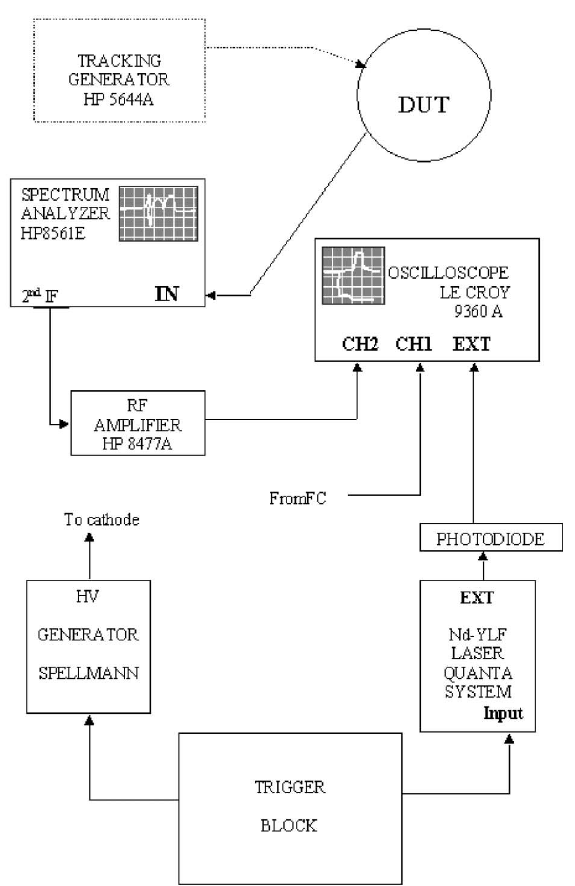
FIG. 2. Scheme for the simultaneous determination of U rf and U FC